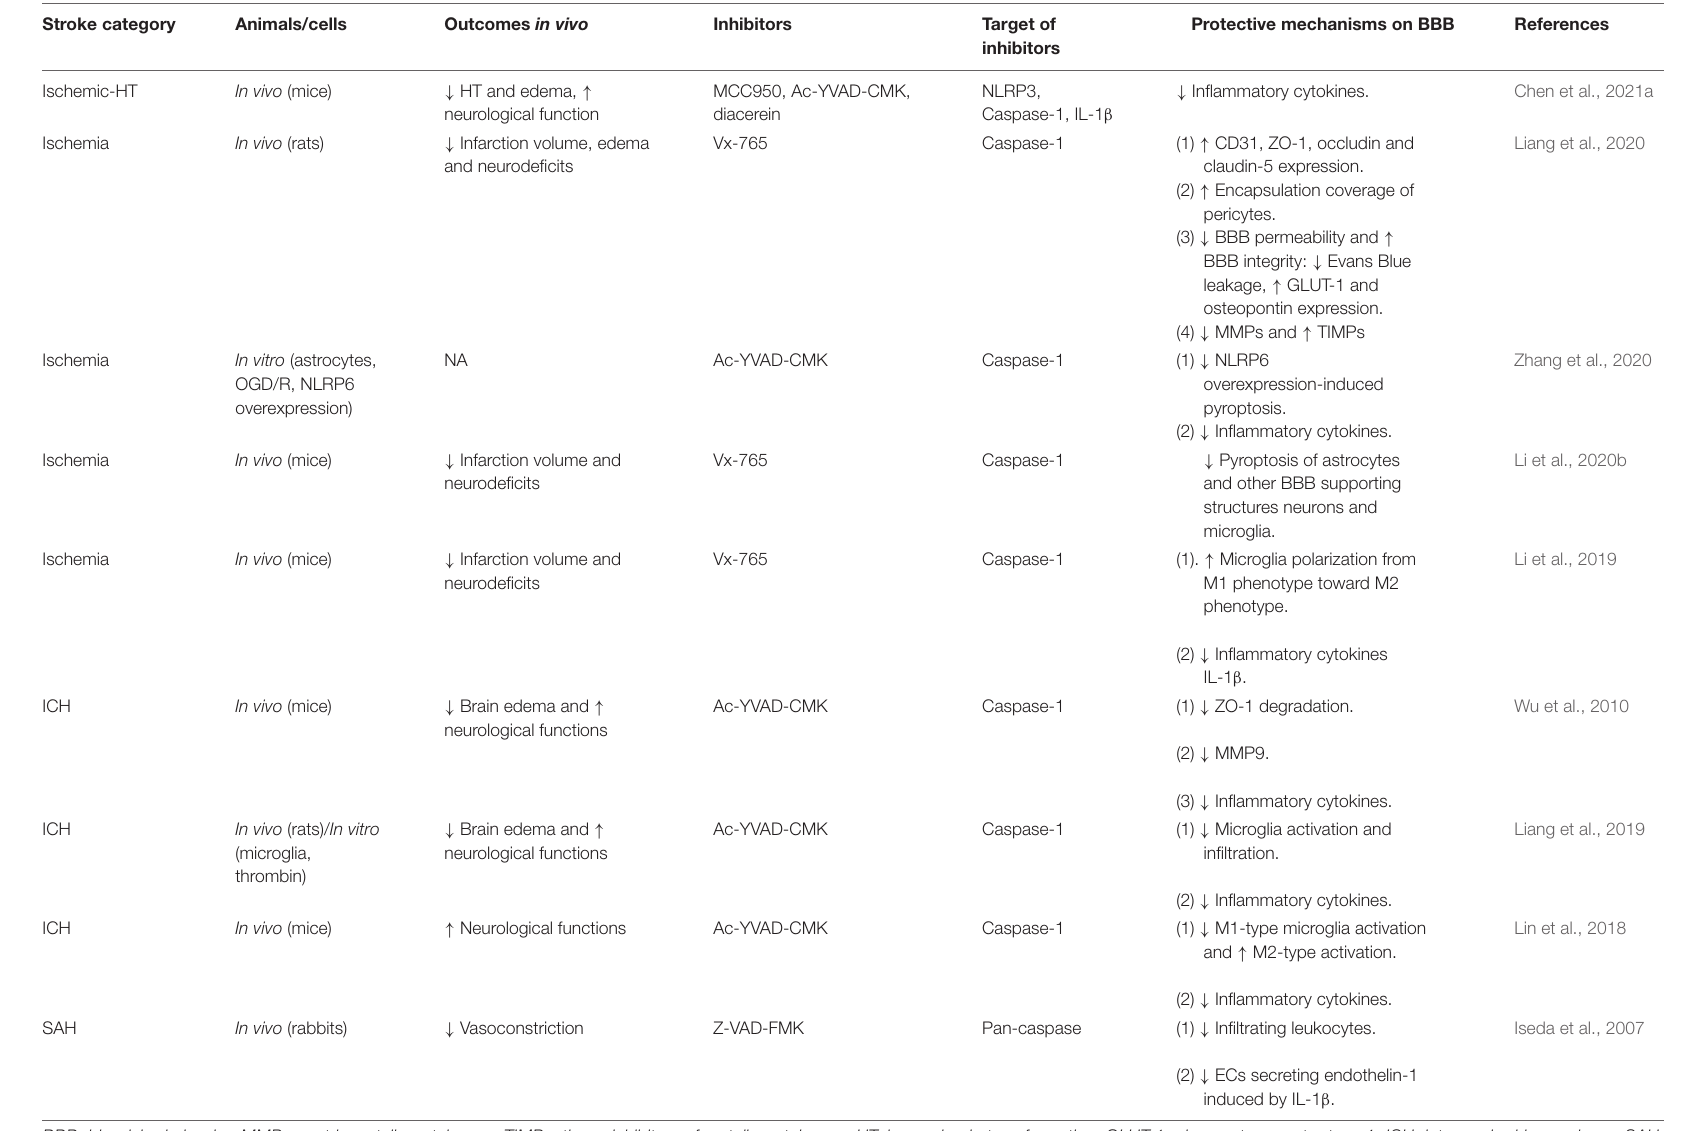
TABLE 1 | The drugs preserving blood-brain barrier integrity via direct caspase-1 inhibition in acute stroke. Stroke